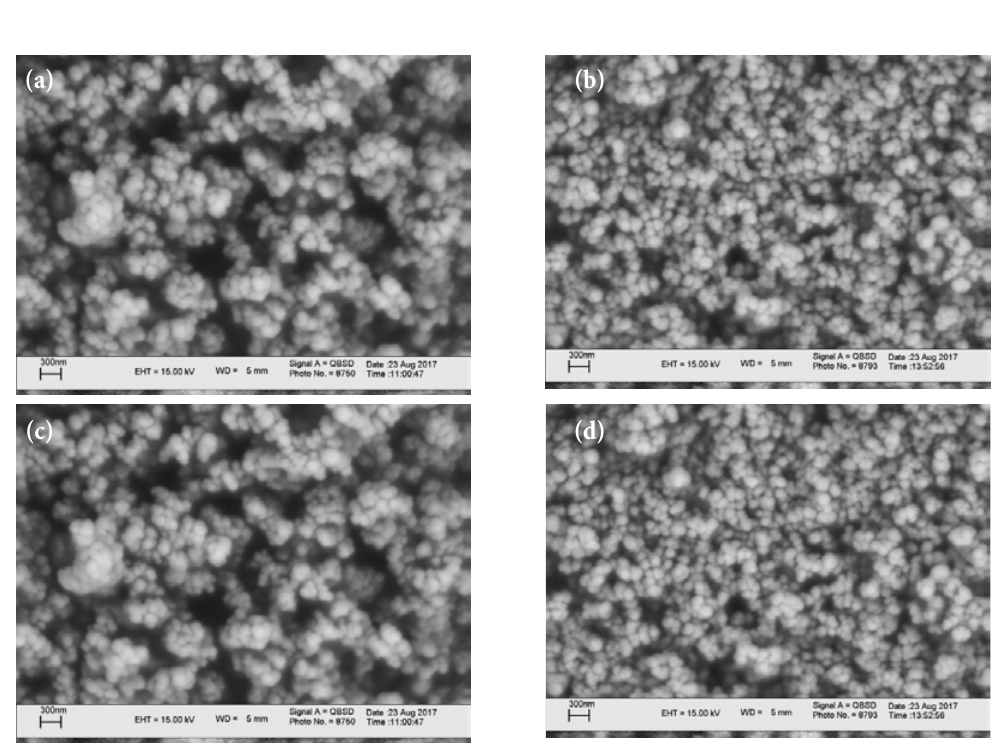
nanoparticles (a) doped with 0.5 (b), 1 (c) and 3% (d) 2